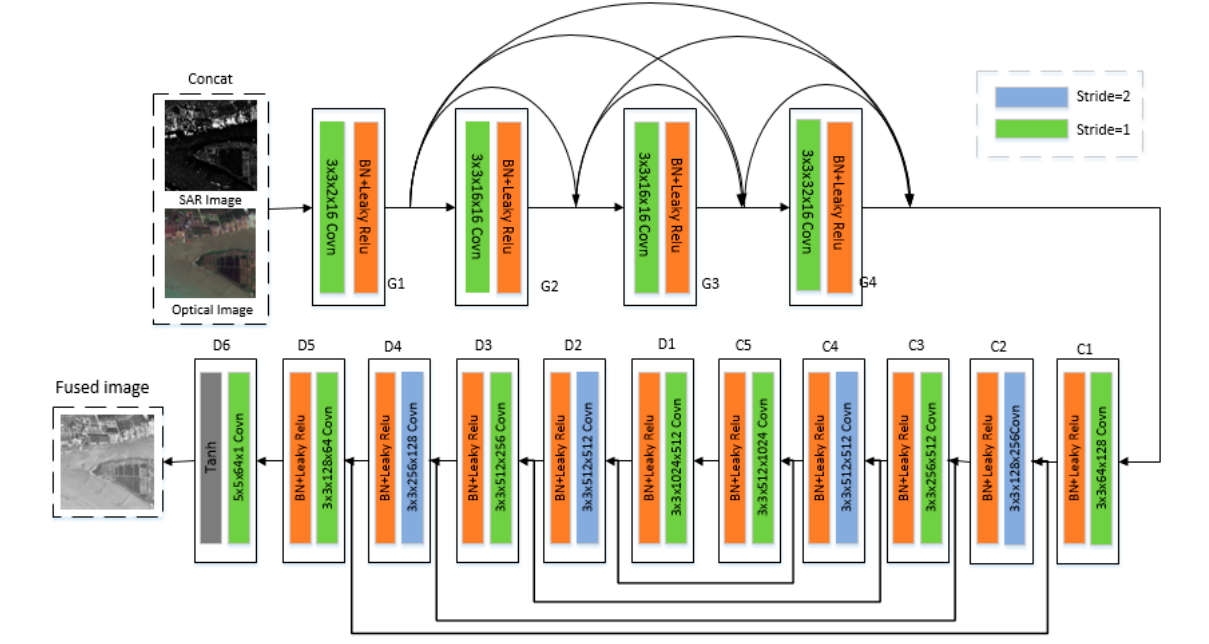
Figure 3. Network architecture of generator.